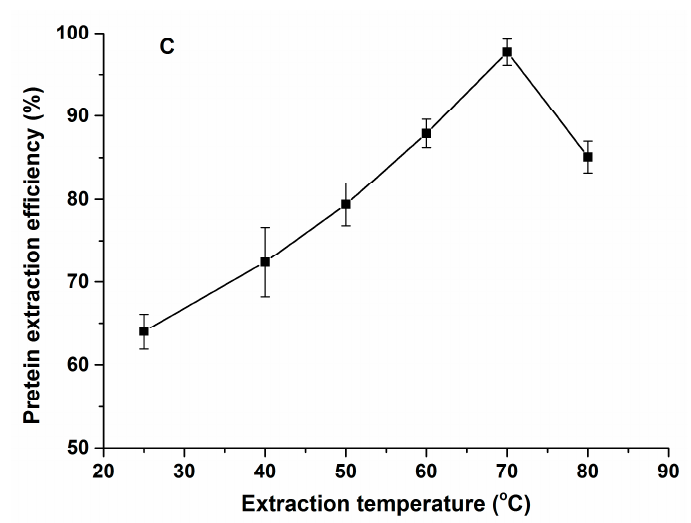
Figure 3. Optimization of sample extraction. Effect of extraction pH ( A ) and ratio between sample and solvent ( B ) on the protein extraction efficiency for the soybean seed; ( C ) effect of extraction temperature on the protein extraction efficiency for the fermented soybean meal.